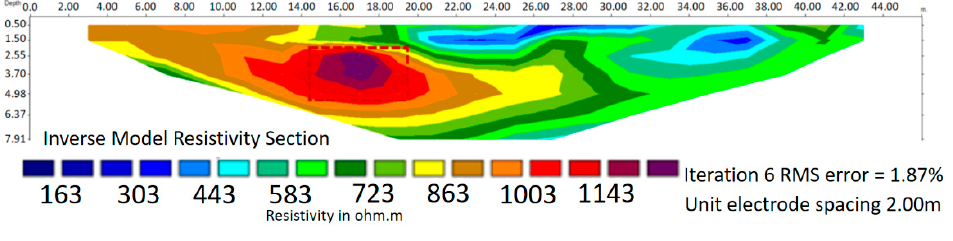
Figure 5. L3 result.